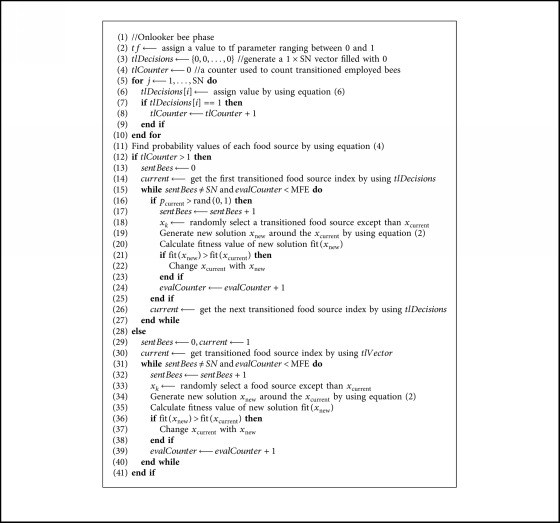
Onlooker bee phase with the tl mechanism.